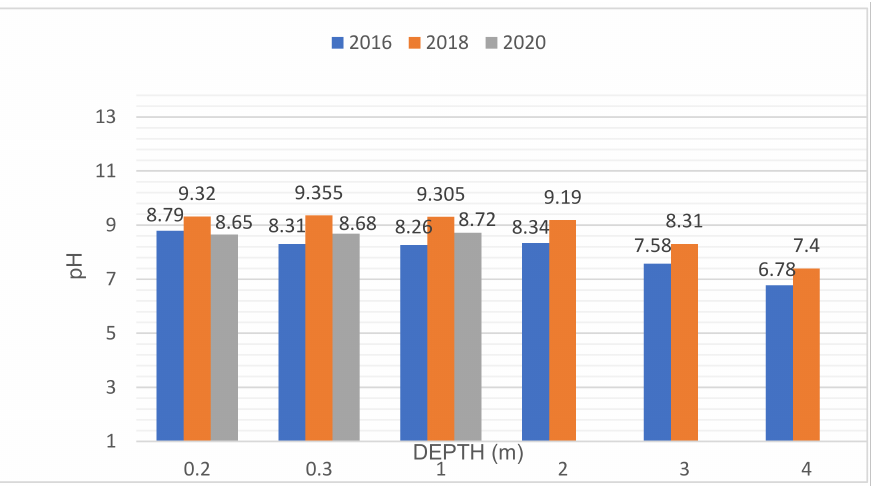
Figure 3. pH values at several depths of Lake Rotund.